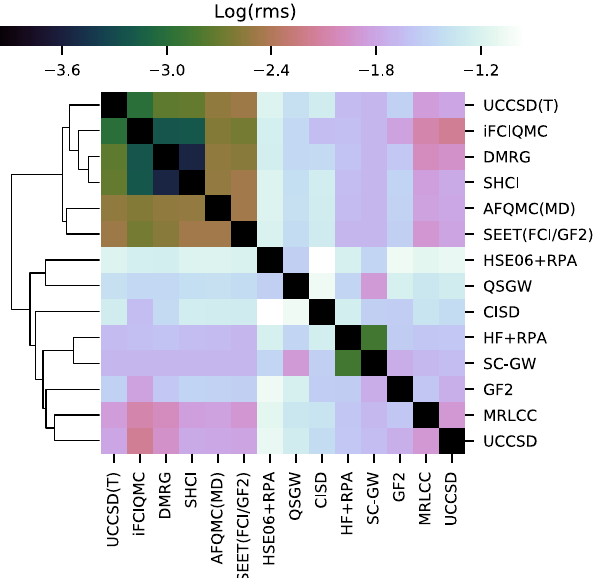
FIG. 1. Cluster analysis of electronic structure methods in this work, using the Seaborn [64] function clustermap. The matrix values are the logarithm of the rms deviation of the total energy in hartrees [Eq. (1)] between the two methods. The methods are ordered according to the “ complete ” distance metric d ð m; n Þ ¼ max ð σ m;n Þ as defined in Eq. (1). The lines on the left are dendrograms which quantify the relationship between the two methods. Closely matching methods are linked with short links, and grouped by their similarity. In Fig. 1, we show a cluster analysis of the total energies using Eq. (1), evaluated on the intersection of basis sets and systems available for both methods, as the distance metric. iFCIQMC, DMRG, and SHCI are converged to very high